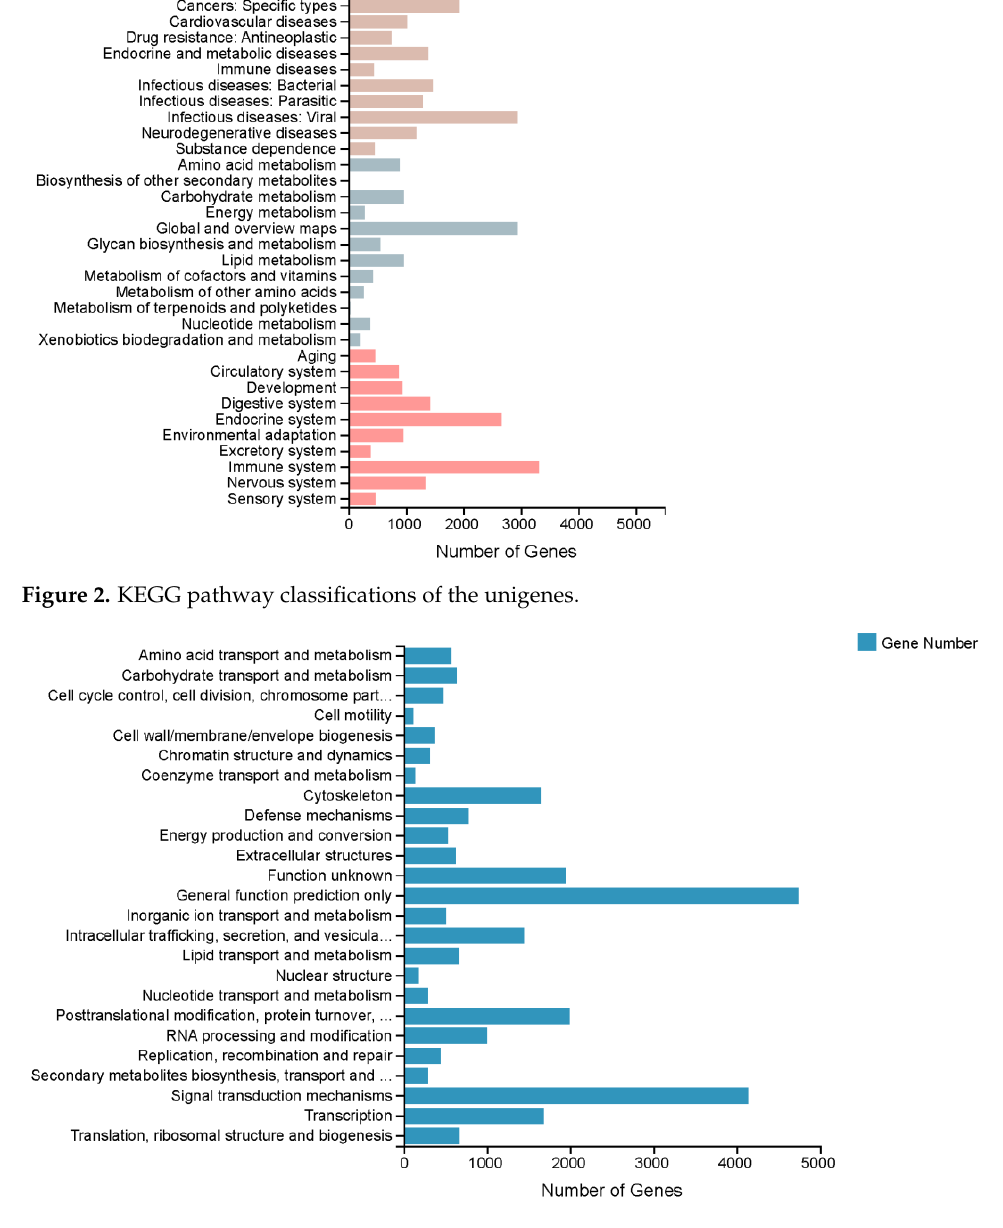
Figure 3. Clusters of KOG functional classifications.